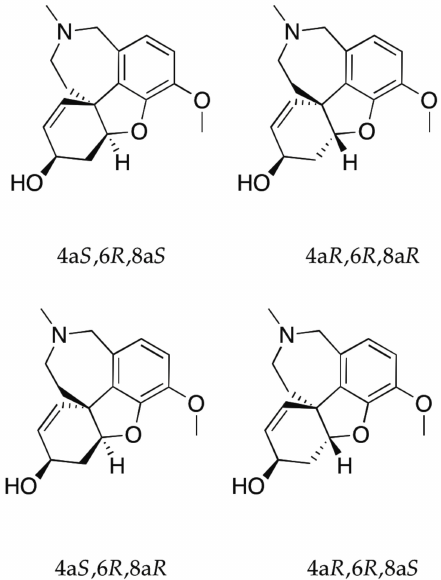
Figure 10. Chemical structures of the four diastereoisomers possible for